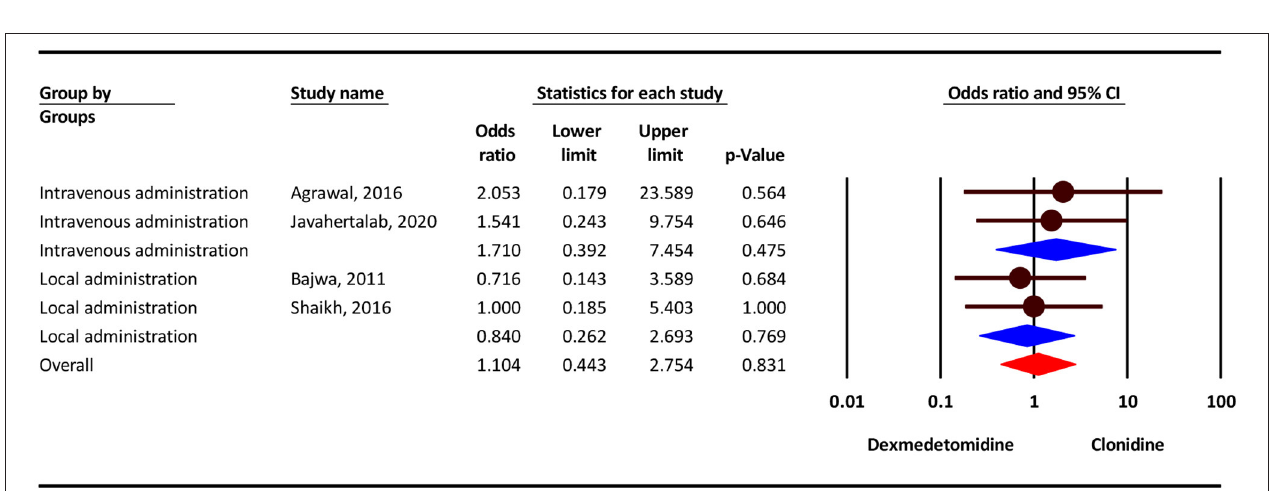
FIGURE 3 | Odds ratio for the risk of Nausea/Vomiting as an adverse event associated with the adjuvant use of dexmedetomidine and clonidine in intravenous and local anesthesia.